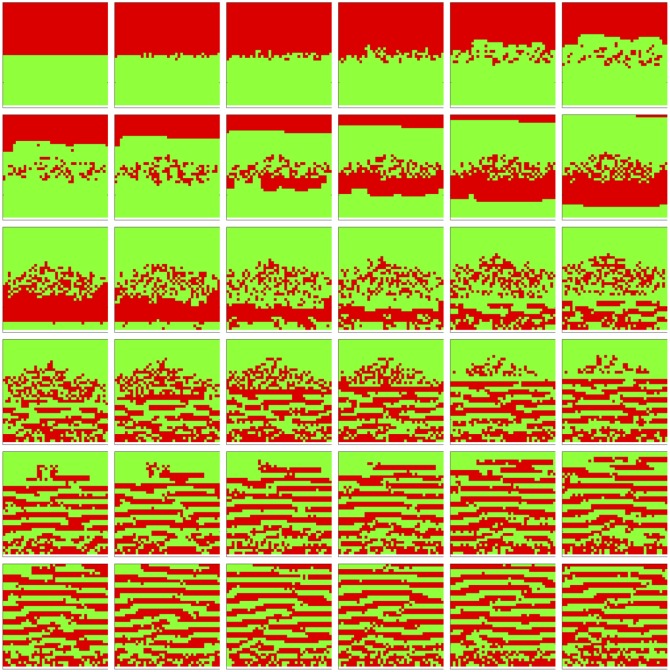
Spatial cell populations during a metabolic symbiosis simulation.Left-to-right, top-to-bottom: 60 generations shown in 36 frames (t = 1, 3, 5, 7, 9, 11, 13, 15, 17, 19, 21, 23, 25, 27, 29, 30, 32, 33, 35, 36, 38, 39, 41, 42, 44, 45, 47, 48, 50, 51, 53, 54, 56, 57, 59, 60). Key: vessel (white), empty (blue), hypoxic (red), aerobic (green) cells.